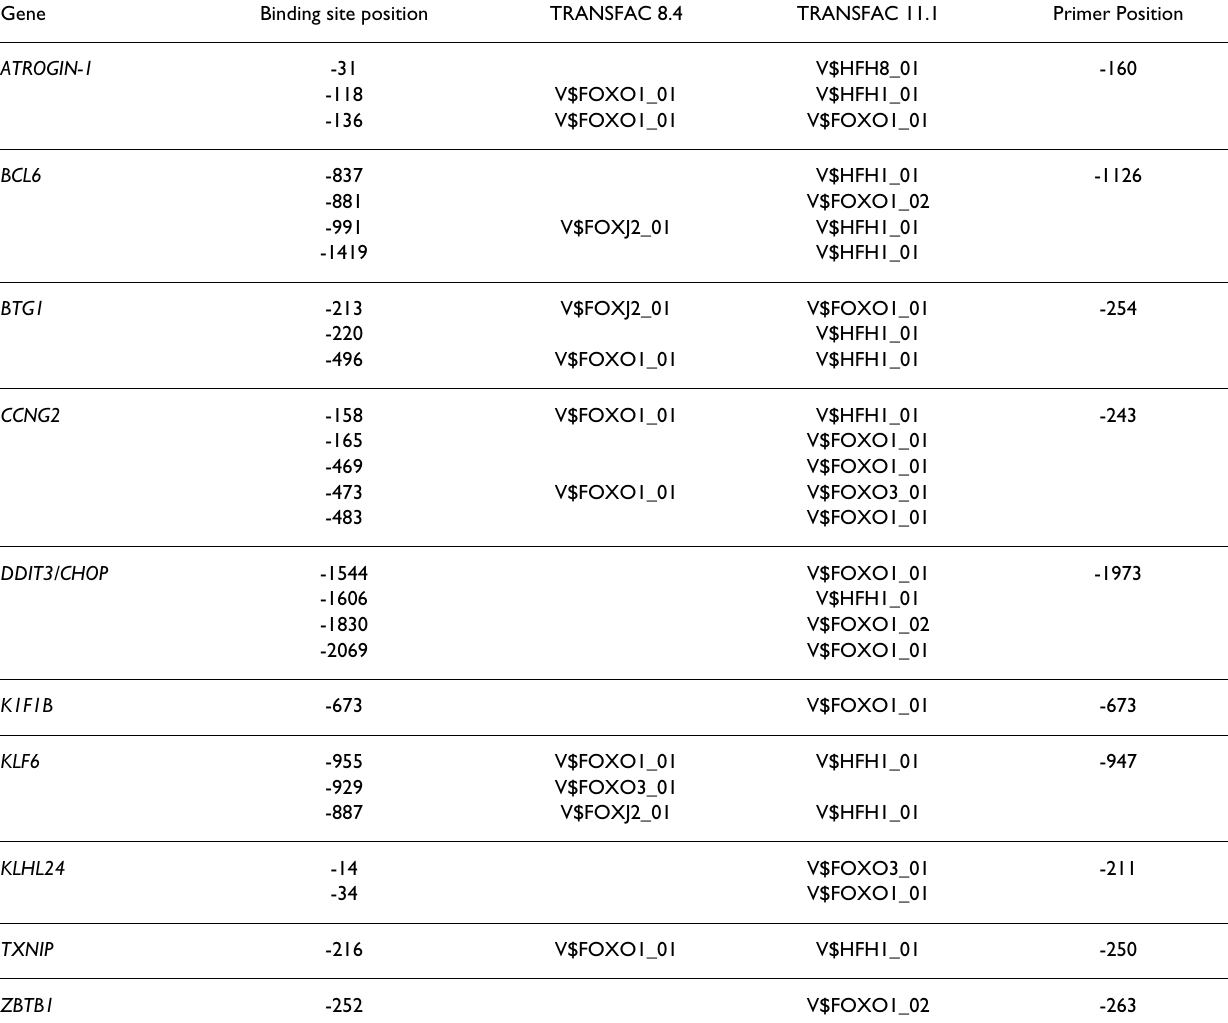
Table 5: FOXO binding sites confirmed by chromatin immunoprecipitation. Gene Binding site